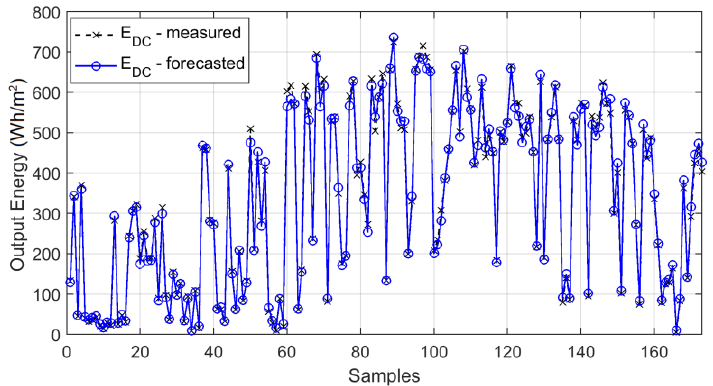
Figure 10. The values of ( E DC ) energy measurements and ( E DC ) energy forecasts obtained from the ANFIS (TSi) model (the test data set, 173 days).